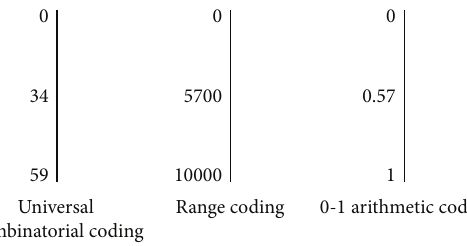
Figure 4: The result of each arithmetic coding.